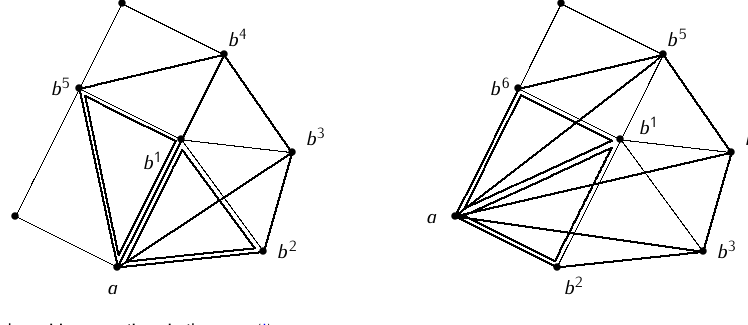
Figure 3. Rings around semi-inner vertices in the case